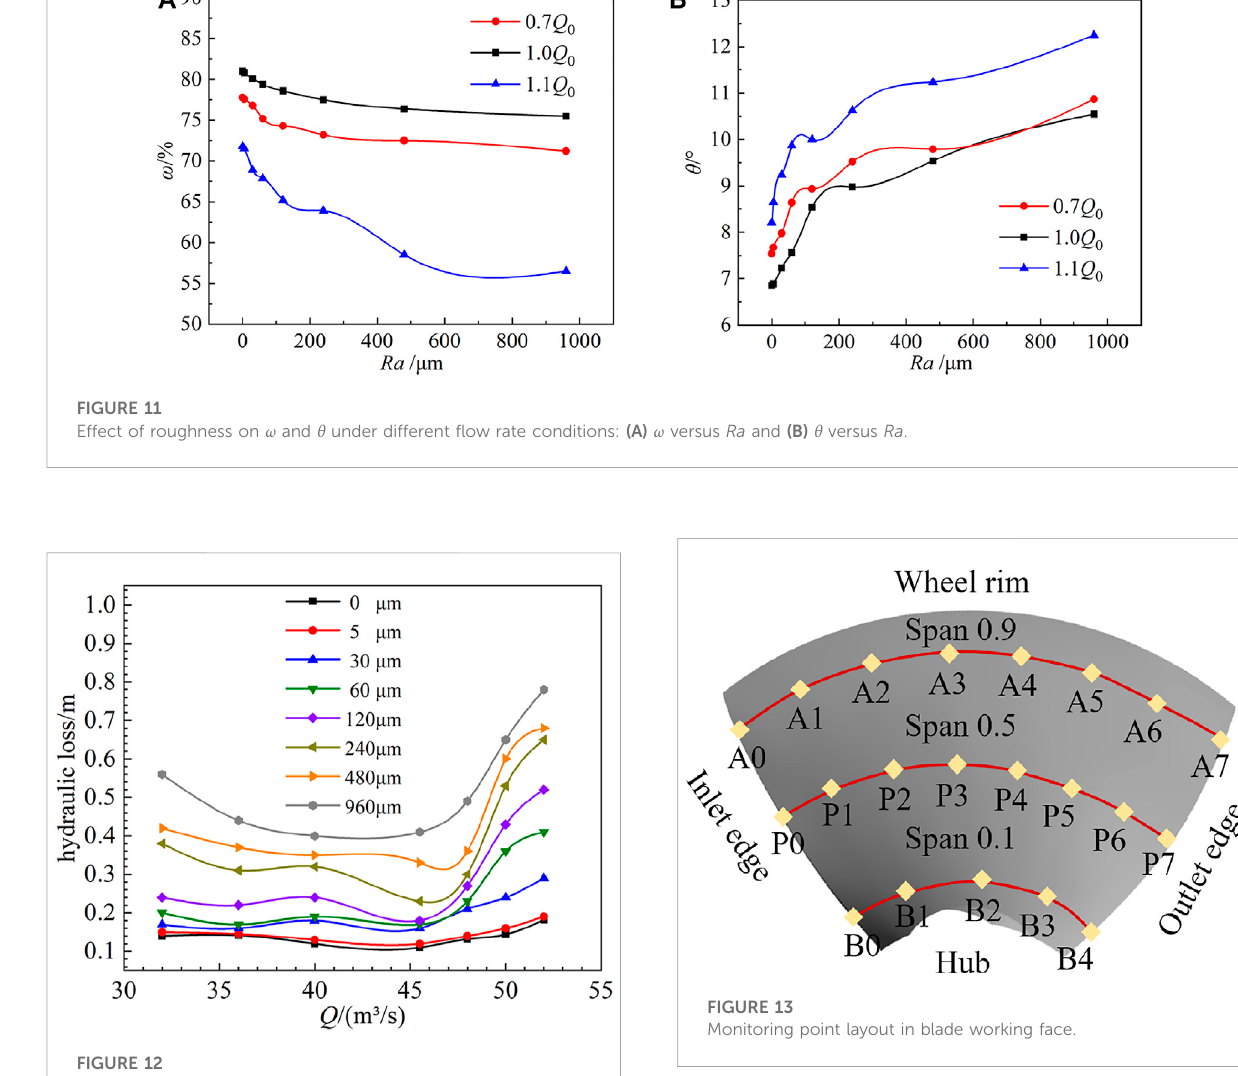
FIGURE 12 Effect of roughness on the hydraulic loss.